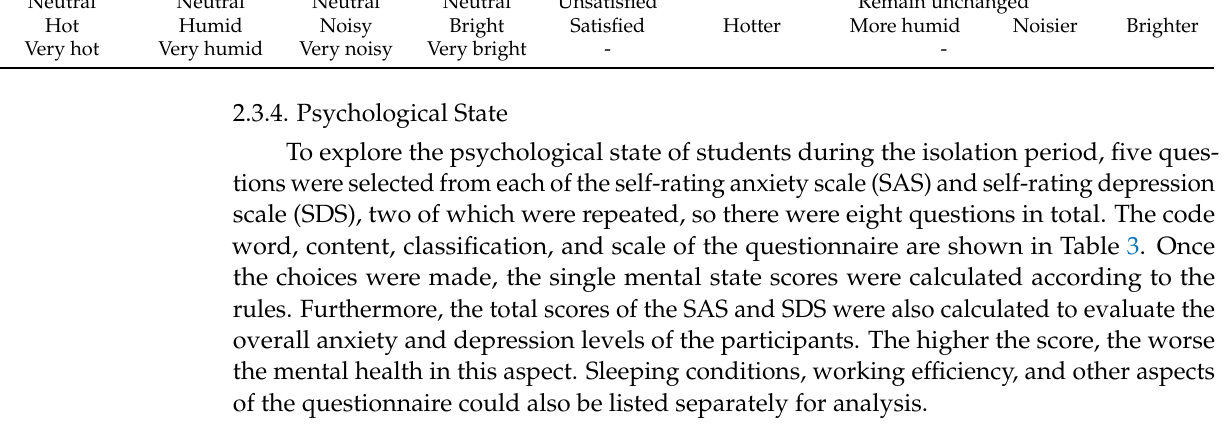
Table 3. Content and scale of the psychological